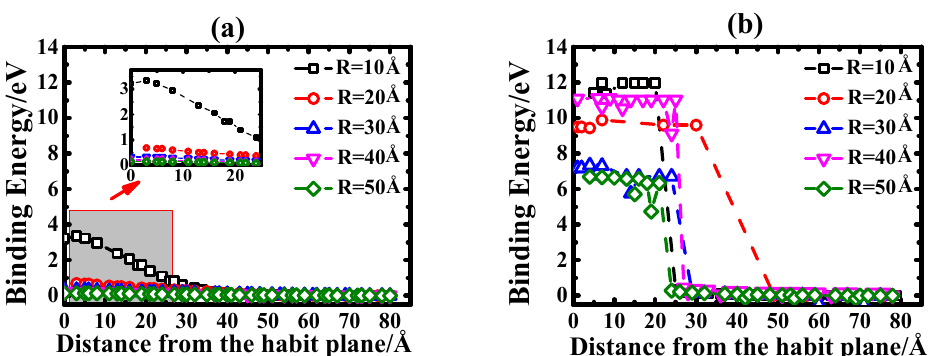
Figure 7. The distribution of binding energies of the different sized IDLs to a vacancy cluster (con- taining eight vacancies) as a function of their distance when the vacancy clusters is placed along the ( a ) Direction I and ( b ) Direction II, respectively. The inset figure shows the binding energies at a small energy scale.